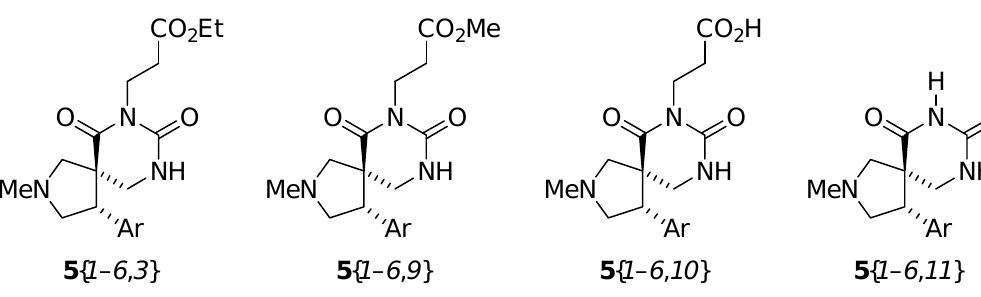
Figure 5. Products formed from the reaction with reagent 13 { 3 }.